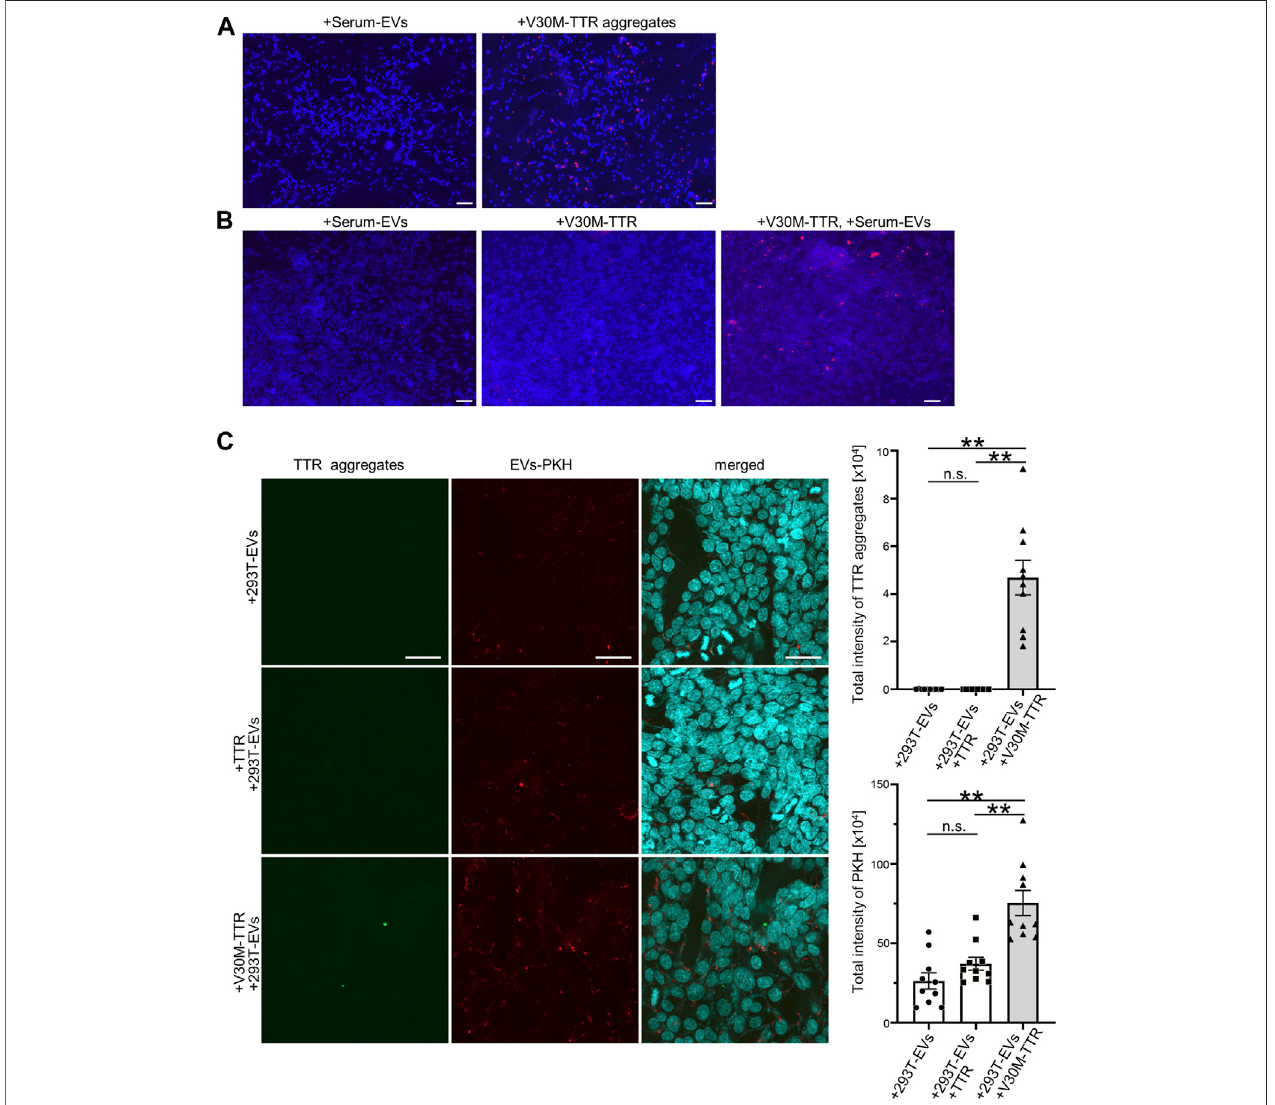
FIGURE 4 | EVs promote the cell deposition of V30M-TTR, and S-EVs change the degree of TTR aggregation and deposition of TTR aggregates on cell lines. (A) TTR aggregates spread on HEK293T. Deposited TTR aggregates were detected by the biotinylated TTR aggregate antibody as red fl uorescence in immunocytochemistry. Bars: 100 μ m. (B) Puri fi ed V30M-TTR monomer, V30M-TTR monomer with S-EVs, and S-EVs spread on HEK293T. HEK293T showed red fl uorescence in only V30M-TTR with S-EVs in appearance. Bars: 100 μ m. (C) Puri fi ed TTR monomer with 293T-EVs, V30M-TTR monomer with 293T-EVs, and 293T-EVsspreadonHEK293T.PKH26-labeled293T-EVsandpuri fi edTTRprotein(WTorV30M)weremixedandincubatedwith293Tcellsat37 ° Cfor24 h.Theuptake ef fi ciency of EVs was quanti fi ed by PKH (right panel), and TTR aggregates were quanti fi ed using anti-aggregated TTR antibody (right panel). TTR aggregates were observed only in the presence of V30M-TTR and EVs under this condition. HEK293T showed green fl uorescence in only V30M-TTR with 293T-EVs in appearance. Red fl uorescenceisindicatedPKH-labeledEVsthatispuri fi edbyultracentrifugationandMagcapturefollowedbyExosomeSpinColumns.Bars:40 μ m.N=10,mean±S.E.; **, p < 0.001; n.s., not signi fi cant, ANOVA with Tukey ’ s post hoc